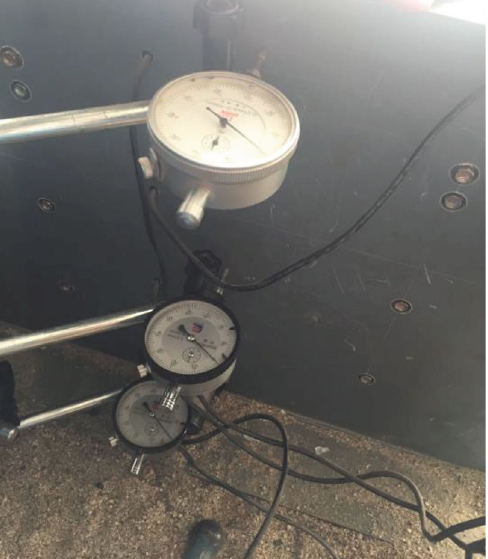
Figure 4: The distribution of earth pressure cells.